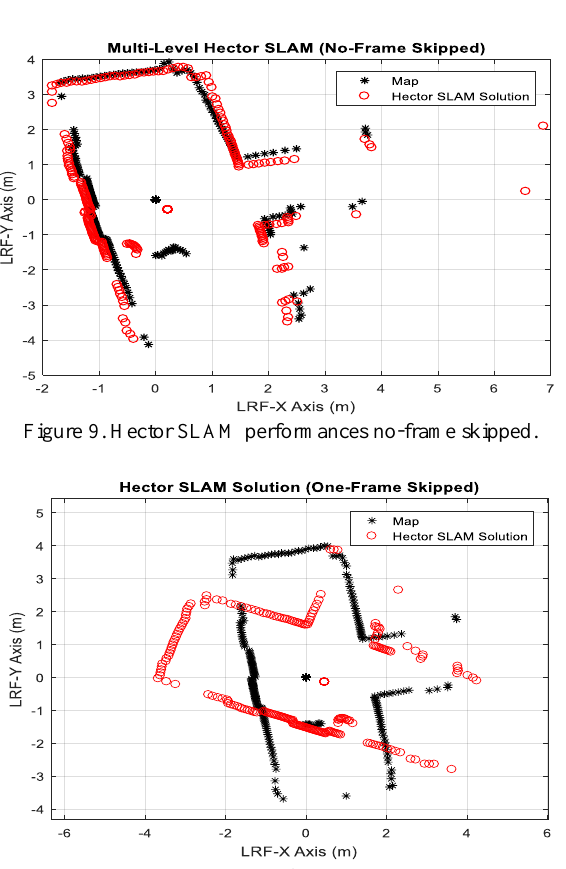
Figure 10. Hector SLAM performances when one-Frame skipping is utilized.